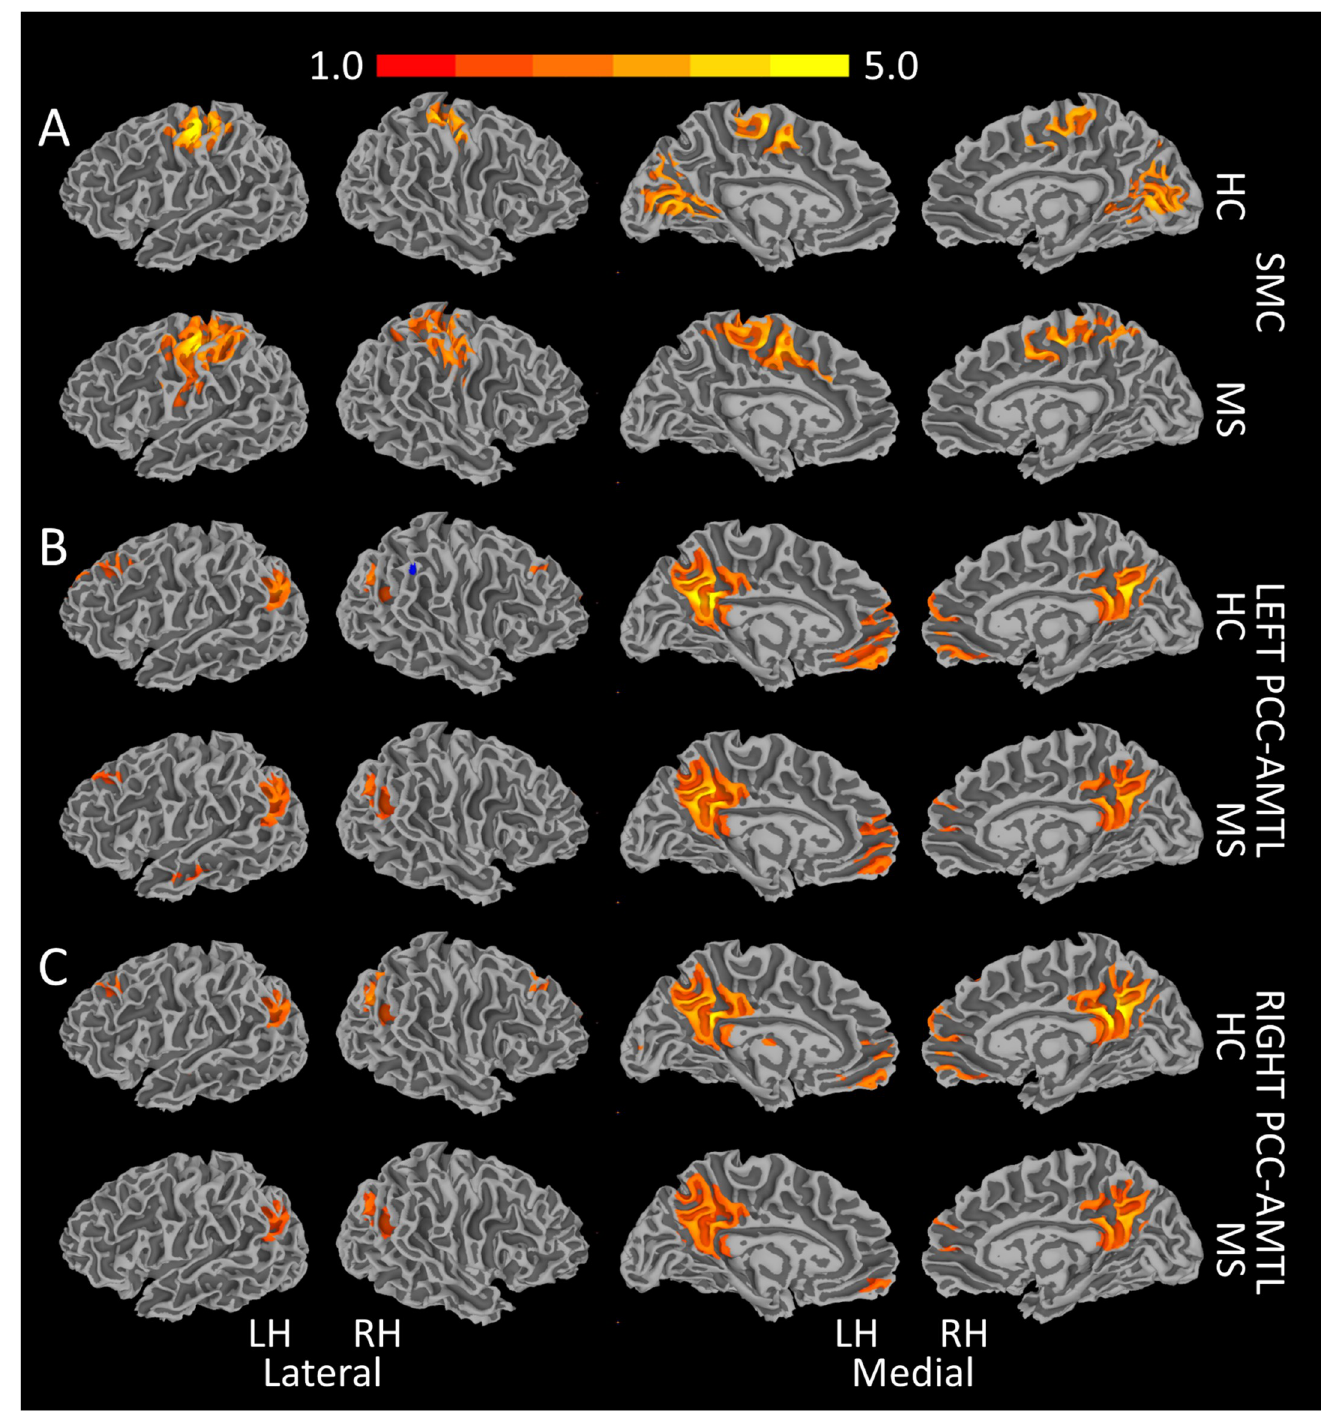
Fig 4. Thresholded group-averaged functional connectivity maps. Single voxel threshold is 1 × 10 − 4 with a cluster requirement of 60 voxels. A. Transcallosal connectivity of the SMC. PCC-AMTL connectivity on the left (B) and right (C). HC = healthy control; LH = left hemisphere; MS = Multiple Sclerosis; PCC-AMTL = posterior cingulate cortex-antero-mesial temporal lobe; RH = right hemisphere; SMC = primary sensorimotor cortices.